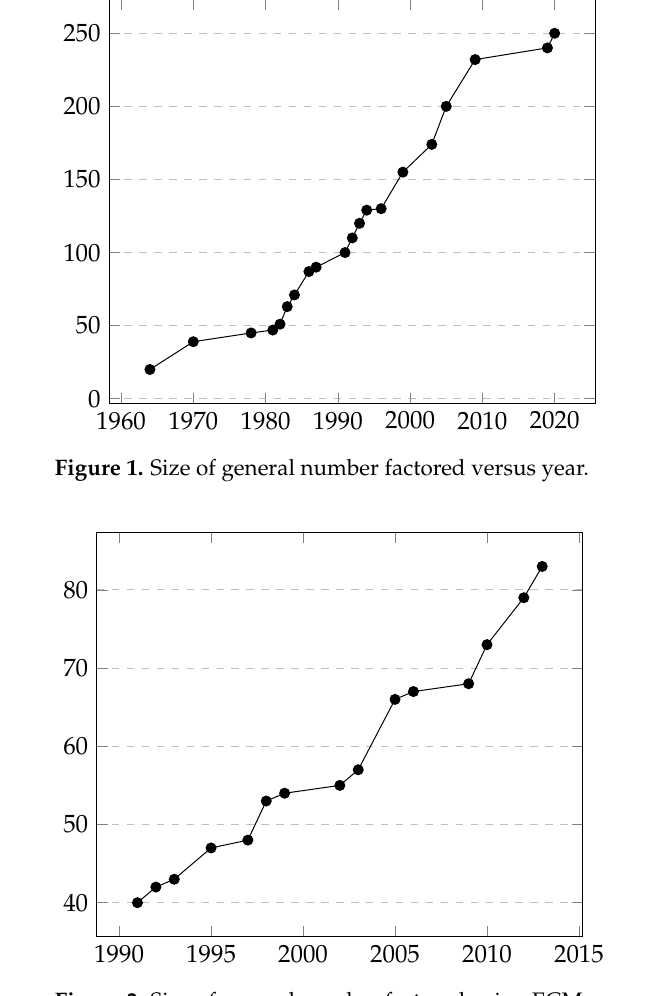
Figure 2. Size of general number factored using ECM versus